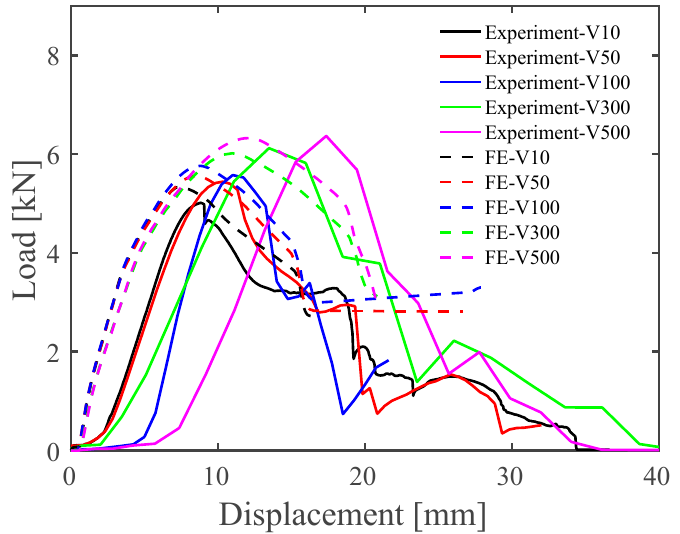
Figure 7. Comparison between the FE results and experimental results regarding load vs. displace- ment at various speeds.